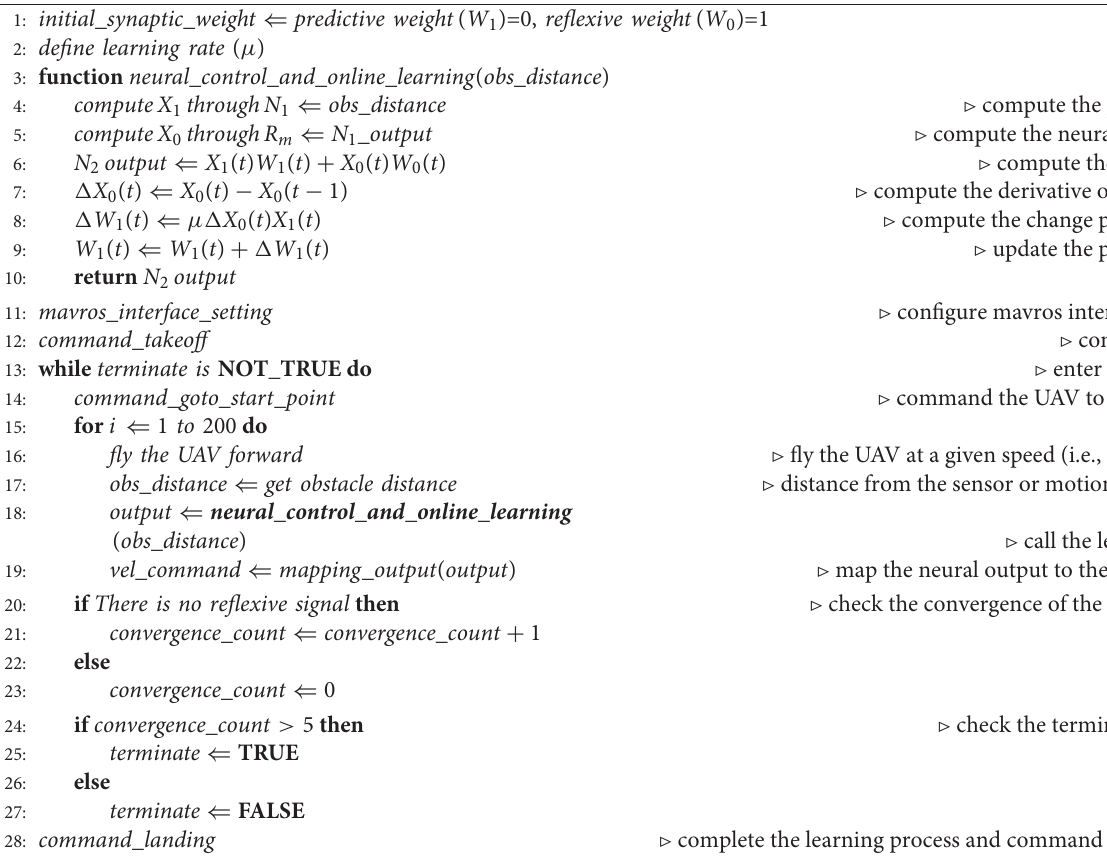
Algorithm 1 Neural Control and Online